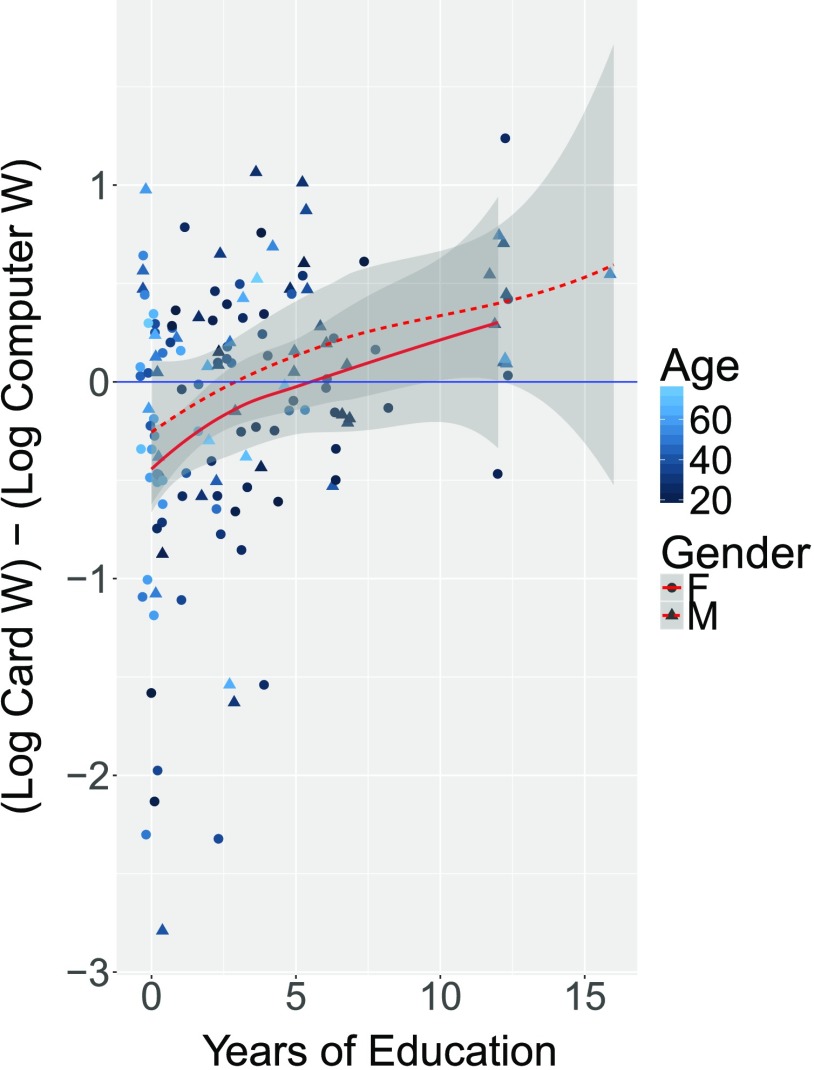
Difference score (Log Cards W minus Log Computer W) as a function of education for males and females separately (which don’t differ significantly). A smoothed nonparametric fit (loess) is shown for each, with 95% confidence bands. This figure demonstrates that for low education, Log Card W is less than Log Computer W (negative values on this plot), meaning that participants perform less well on computer tasks. However, the positive trend of the red average line indicates that the effect disappears and potentially reverses for high education. In addition, this figure reveals no obvious trends with respect to age and the difference score, but one can see that high-education participants tend to be younger and male, reflecting current Tsimane’ demographics.